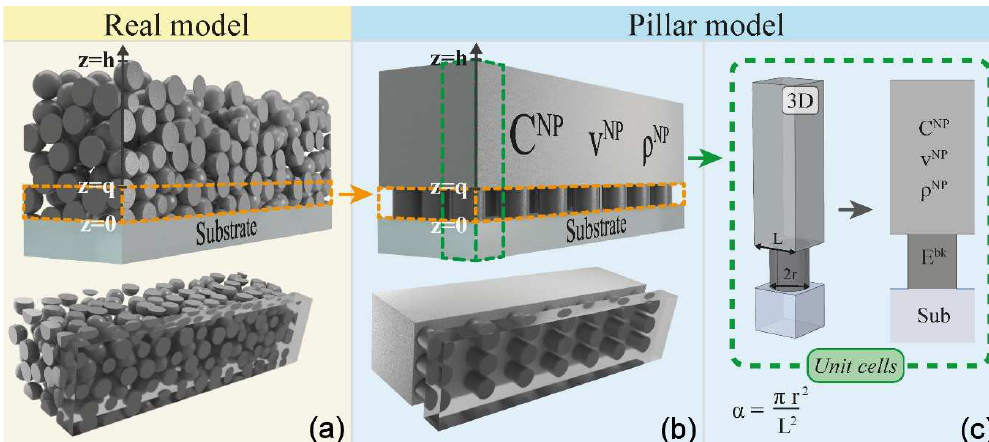
Figure 9. ( a ) 3D nanoparticle thin film of thickness h adhered on a semi-infinite substrate. The bottom view, as seen looking across the substrate, highlights the “patched” interface. ( b ) 3D pillar model: effective NP layer ( q < z < h ); pillars layer (0 < z < q ); semi-infinite substrate ( z < 0). The bottom view, as seen looking across the substrate, highlights the similarity with the “patched” interface of the real case. ( c ) Reduction of the periodic 3D pillar model to a single 3D unit cell of base size L * L . Adapted from ref.